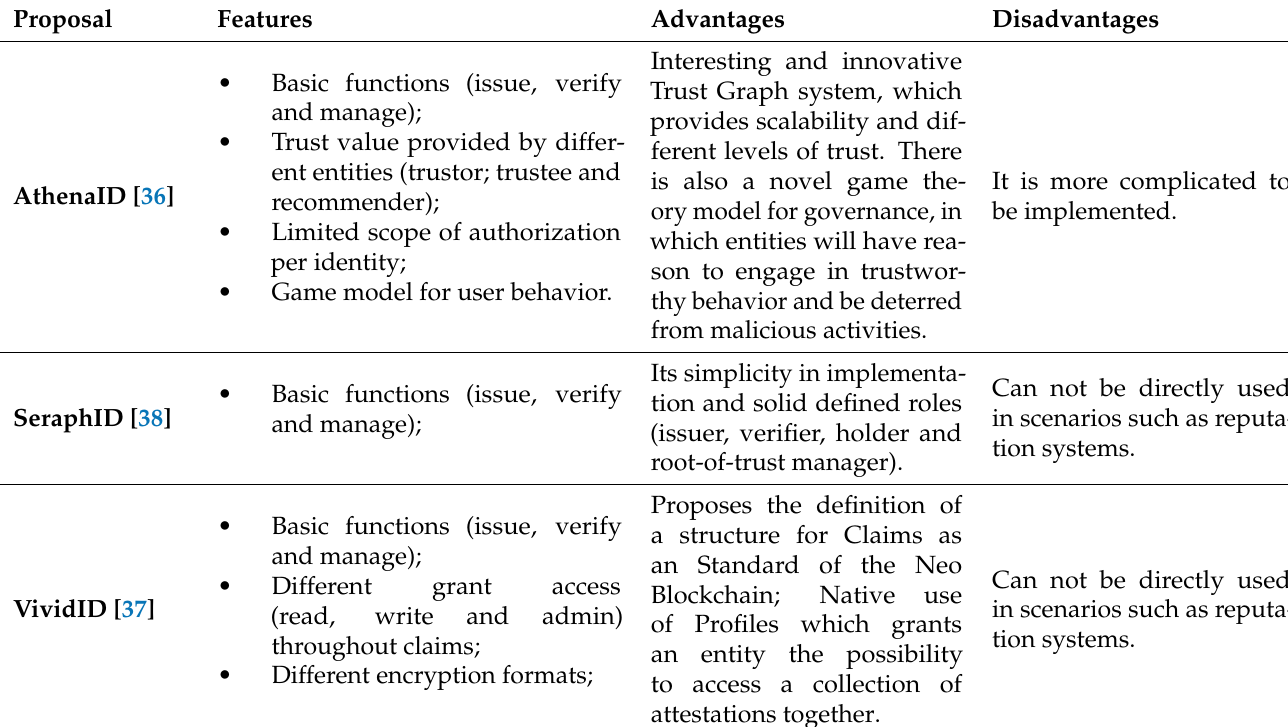
Table 1. Comparisons of proposed digital identities for Neo